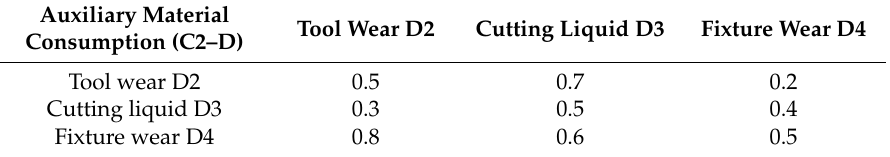
Table 8. Layer judgment matrix (C2–D).